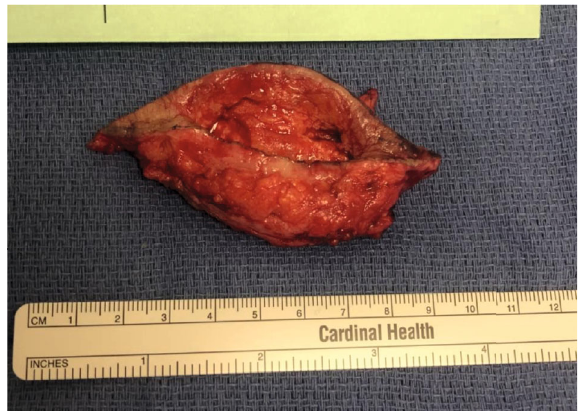
Figure 3: Excised abdominal wound and skin edges (7.75 cm).